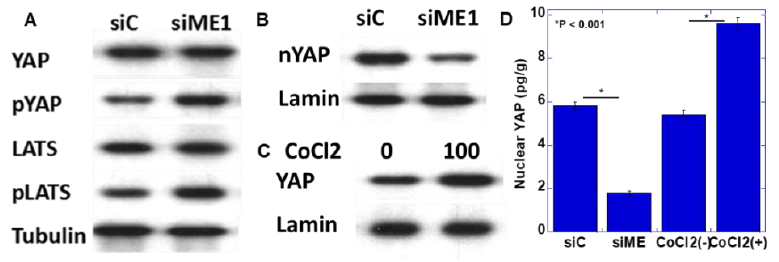
Figure 5. E ff ect of ME1 and hypoxia on yes-associated protein (YAP) activation in HSC4 OSCC